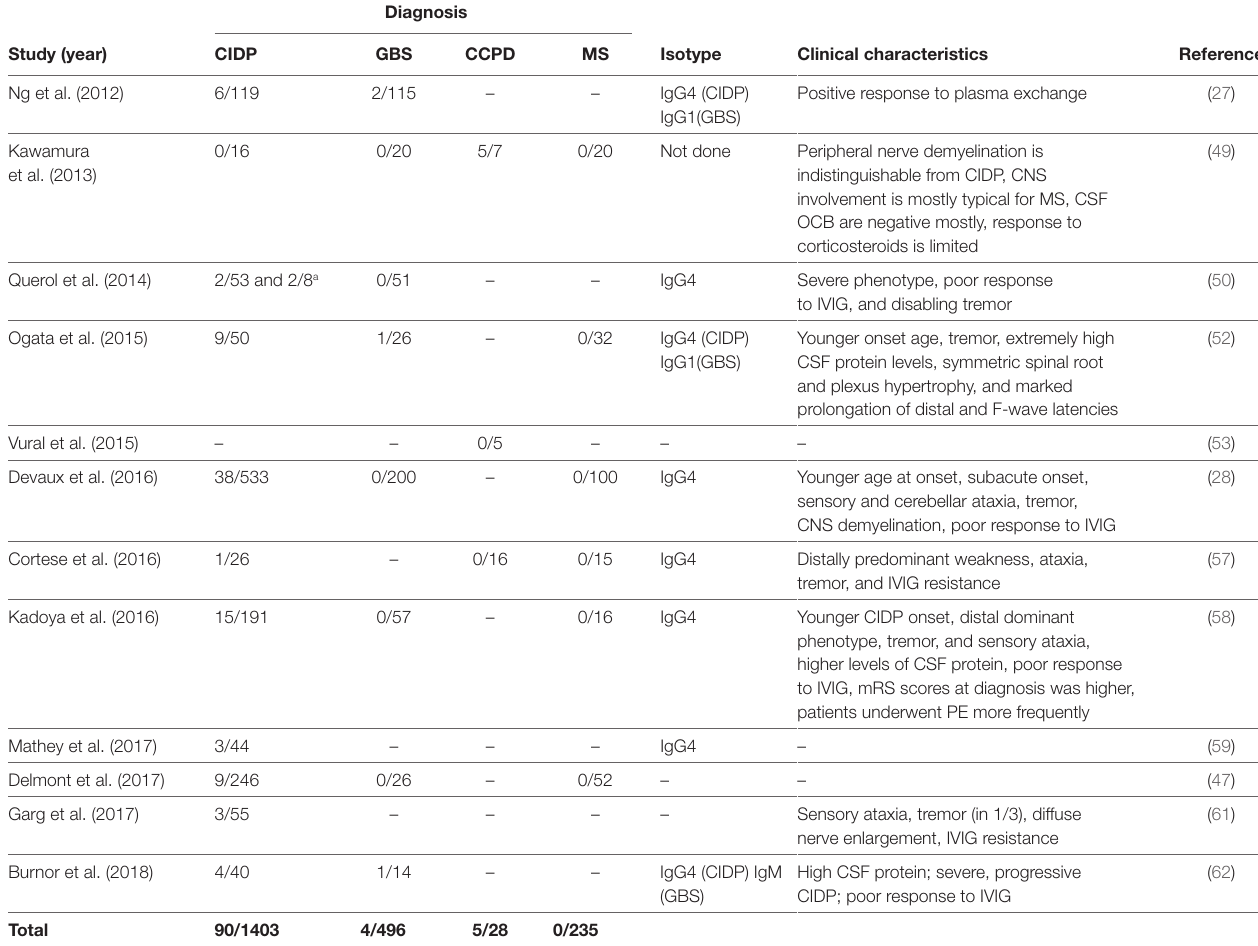
TABLe 3 | Studies that tested autoantibodies against neurofascin 155 (NF155) by using native human